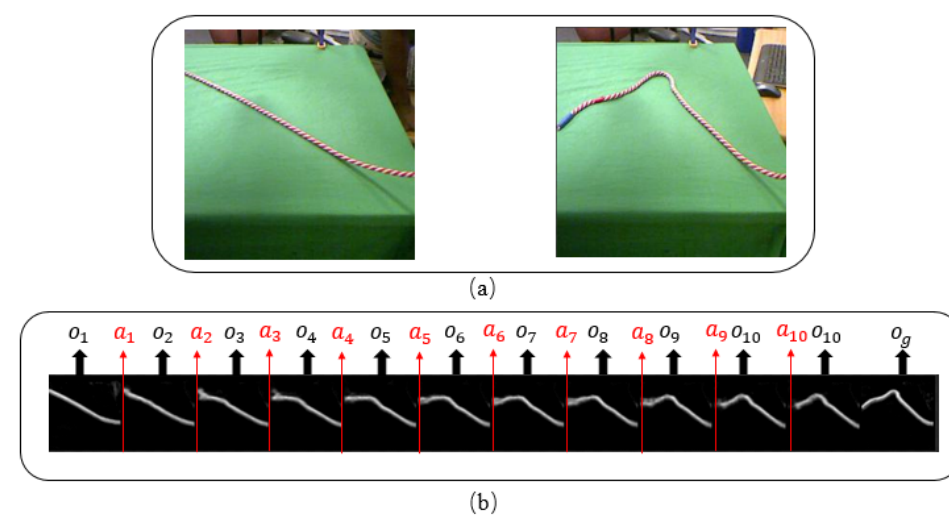
Figure 1. ( a )Examples of initial observations and goal observations in rope domain. ( b ) Examples of 10 step trajectory, given the initial and goal observations in ( a